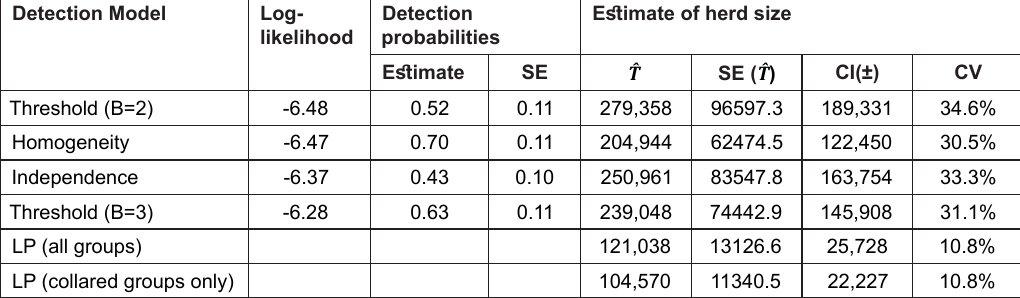
A threshold Rivest model with groups of 2 or more collars having detection probabilities of 1 had the highest likelihood. Groups with less than 2 collars had detection probabilities of